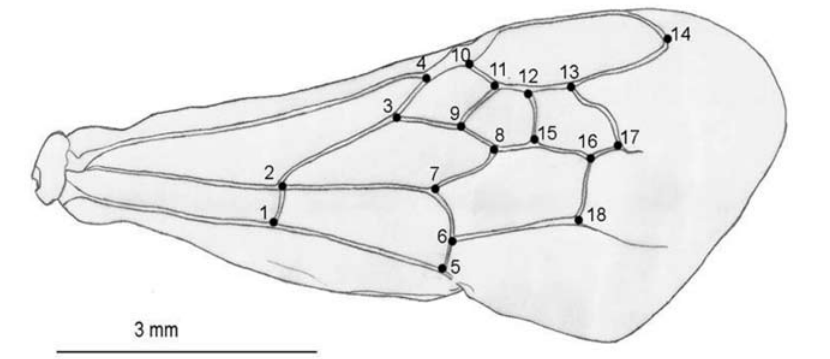
Fig. 1 – Landmarks used for geometric morphometric analysis of the forewing Tetrapedia diversipes